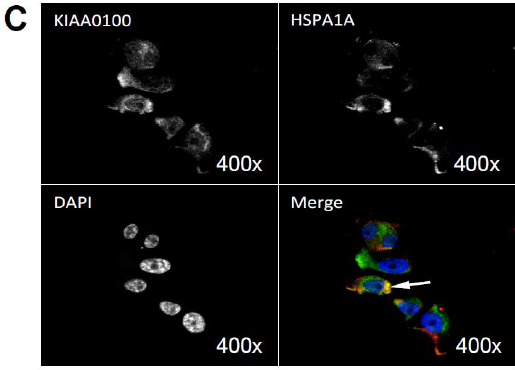
Figure 8. Immunofluorescence of KIAA0100 in MDA-MB-231 cells by con-focal microscope. ( A ) Immunofluorescence of KIAA0100 in MDA-MB-231 cells by con-focal MDA-MB-231 cells stained with of KIAA0100 and microtubules TUBA (arrow point to yellow); ( B ) MDA-MB-231 cells stained with KIAA0100 and Phalloidin (F-actin); ( C ) MDA-MB-231 cells stained with KIAA0100 and HSPA1A (arrow point to the yellow spot). KIAA0100 showed as green, other targets showed in red color.